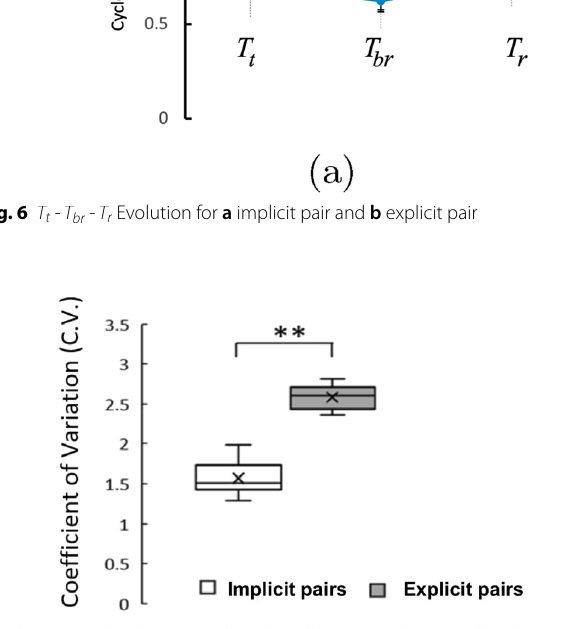
Fig. 7 Coefficient of Variation of the Relative Distance (cid:31)